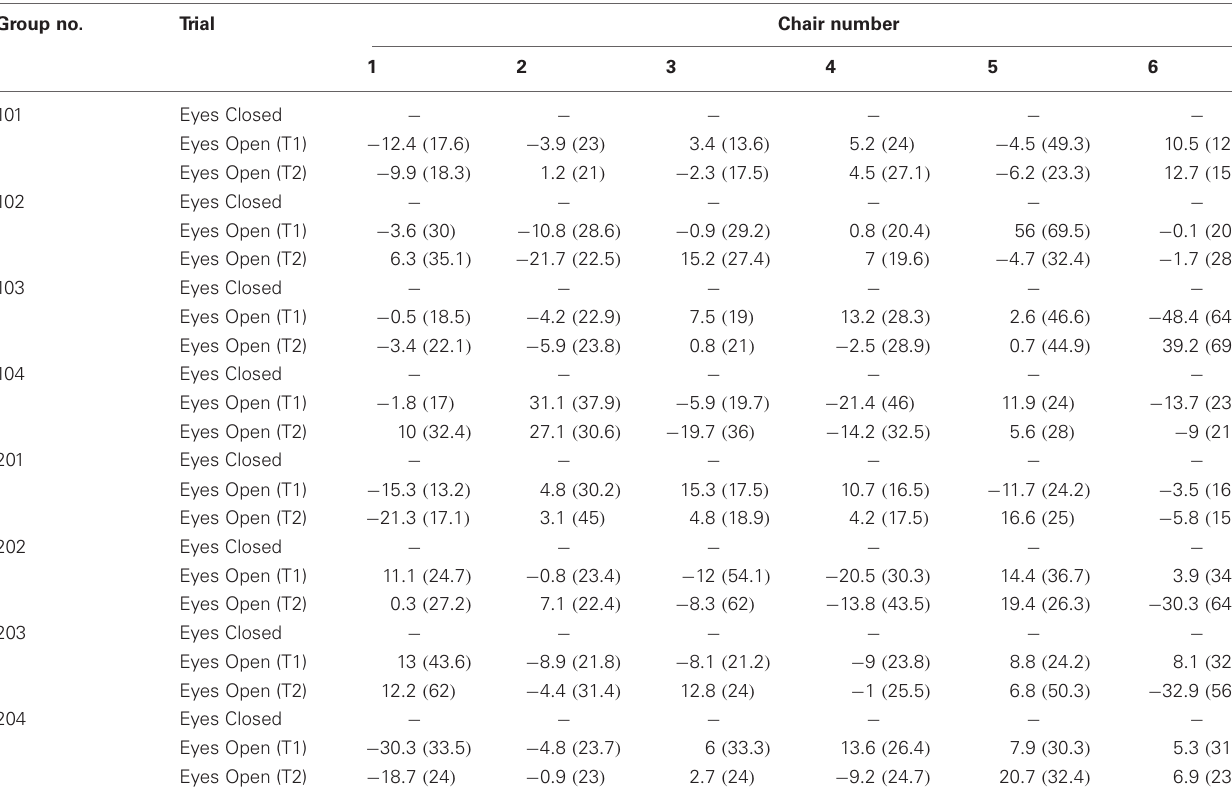
Table 1 | Mean (SD) cluster relative phase ( φ clus. and SD φ clus. , respectively). Group